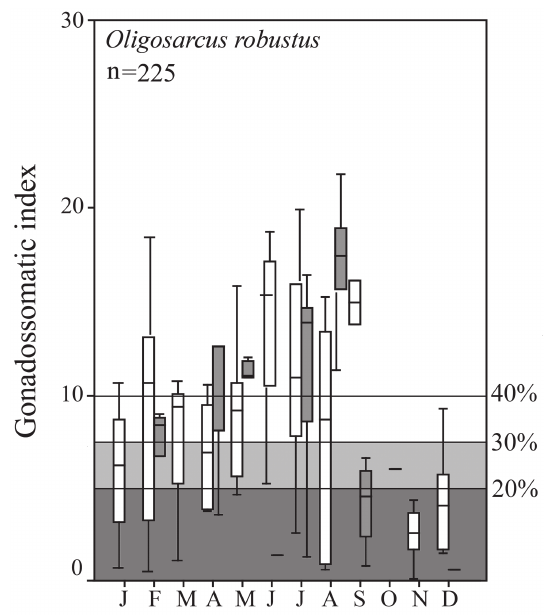
Fig. 6. Monthly variation of Oligosarcus robustus GSI values (adult females only) in Guaíba Lake (white) and Casamento Lake (dark gray), Rio Grande do Sul, Brazil (median, 25-75% quartiles and lower-upper GSI limits by month and site). Three GSI cut-off values were tested with respect to the maximum GSI recorded for each species, for delimitation of